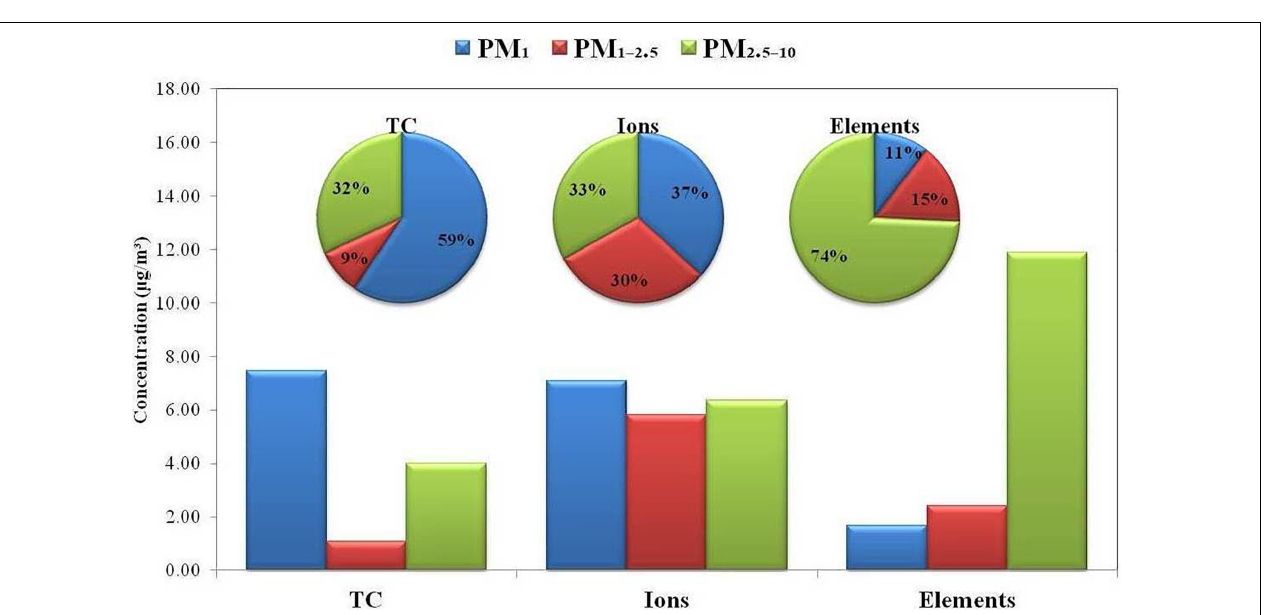
FIGURE 2 | Temporal trends of the PM 1 , PM 1 - 2 . 5 , and PM 2 . 5 - 10 concentrations ( µ g/m 3 ) and the PM 1 /PM 10 , PM 1 - 2 . 5 /PM 10 , and PM 2 . 5 - 10 /PM 10 ratios.